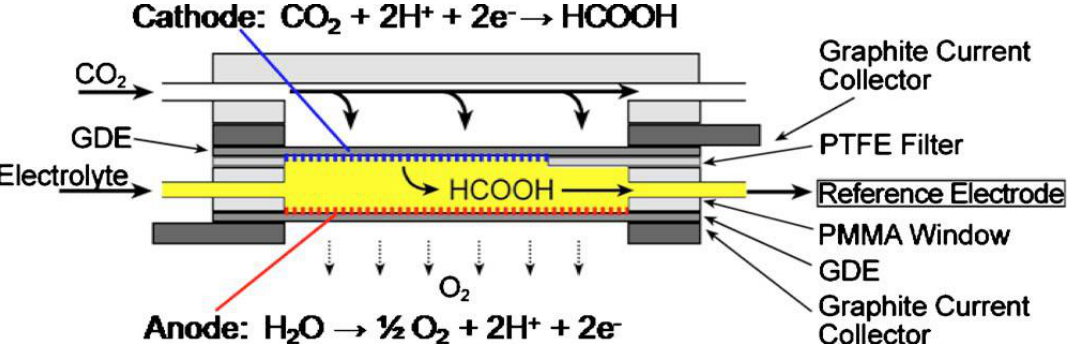
Figure 17. Schematic diagram of the microfluidic reactor for CO 2 conversion. Reprinted from Ref. [151], copyright (2010), with permission from the Electrochemical Society.